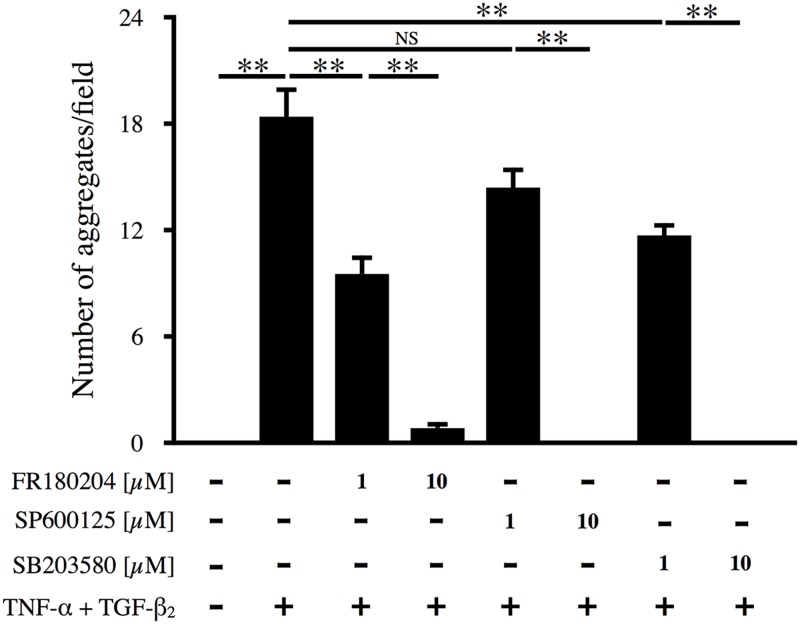
Effect of MAPK inhibitors on aggregate formation.Inhibitors of ERK (FR18004), JNK (SP600125), and p38 (SB203580) were added to the culture medium at 1 h before TNF-α/TGF-β2 co-stimulation. The number of cellular aggregates per microscopic field was counted and analyzed (n = 6).